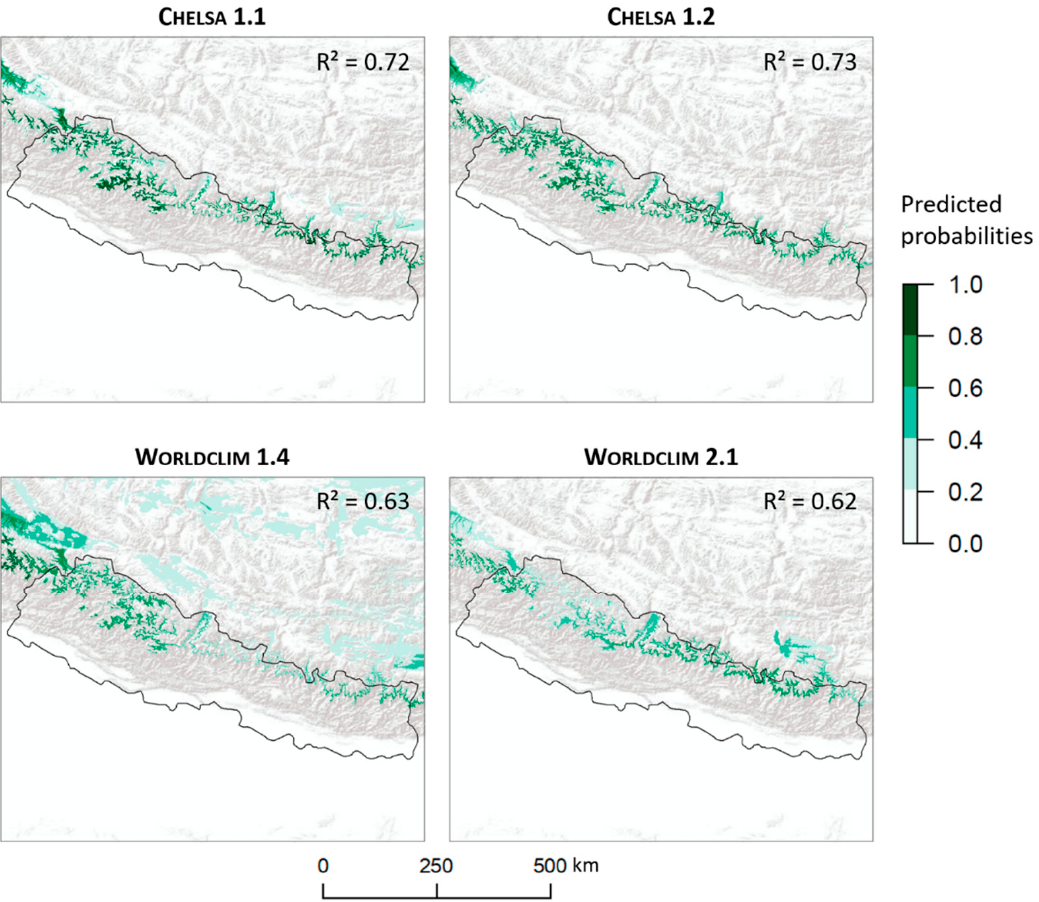
Figure 5. Comparison of continuous model predictions for the potential distribution of Betula utilis under current climate conditions for C HELSA and W ORLDCLIM and respective versions. Evaluation of modeling results was based on Pseudo R 2 [54].